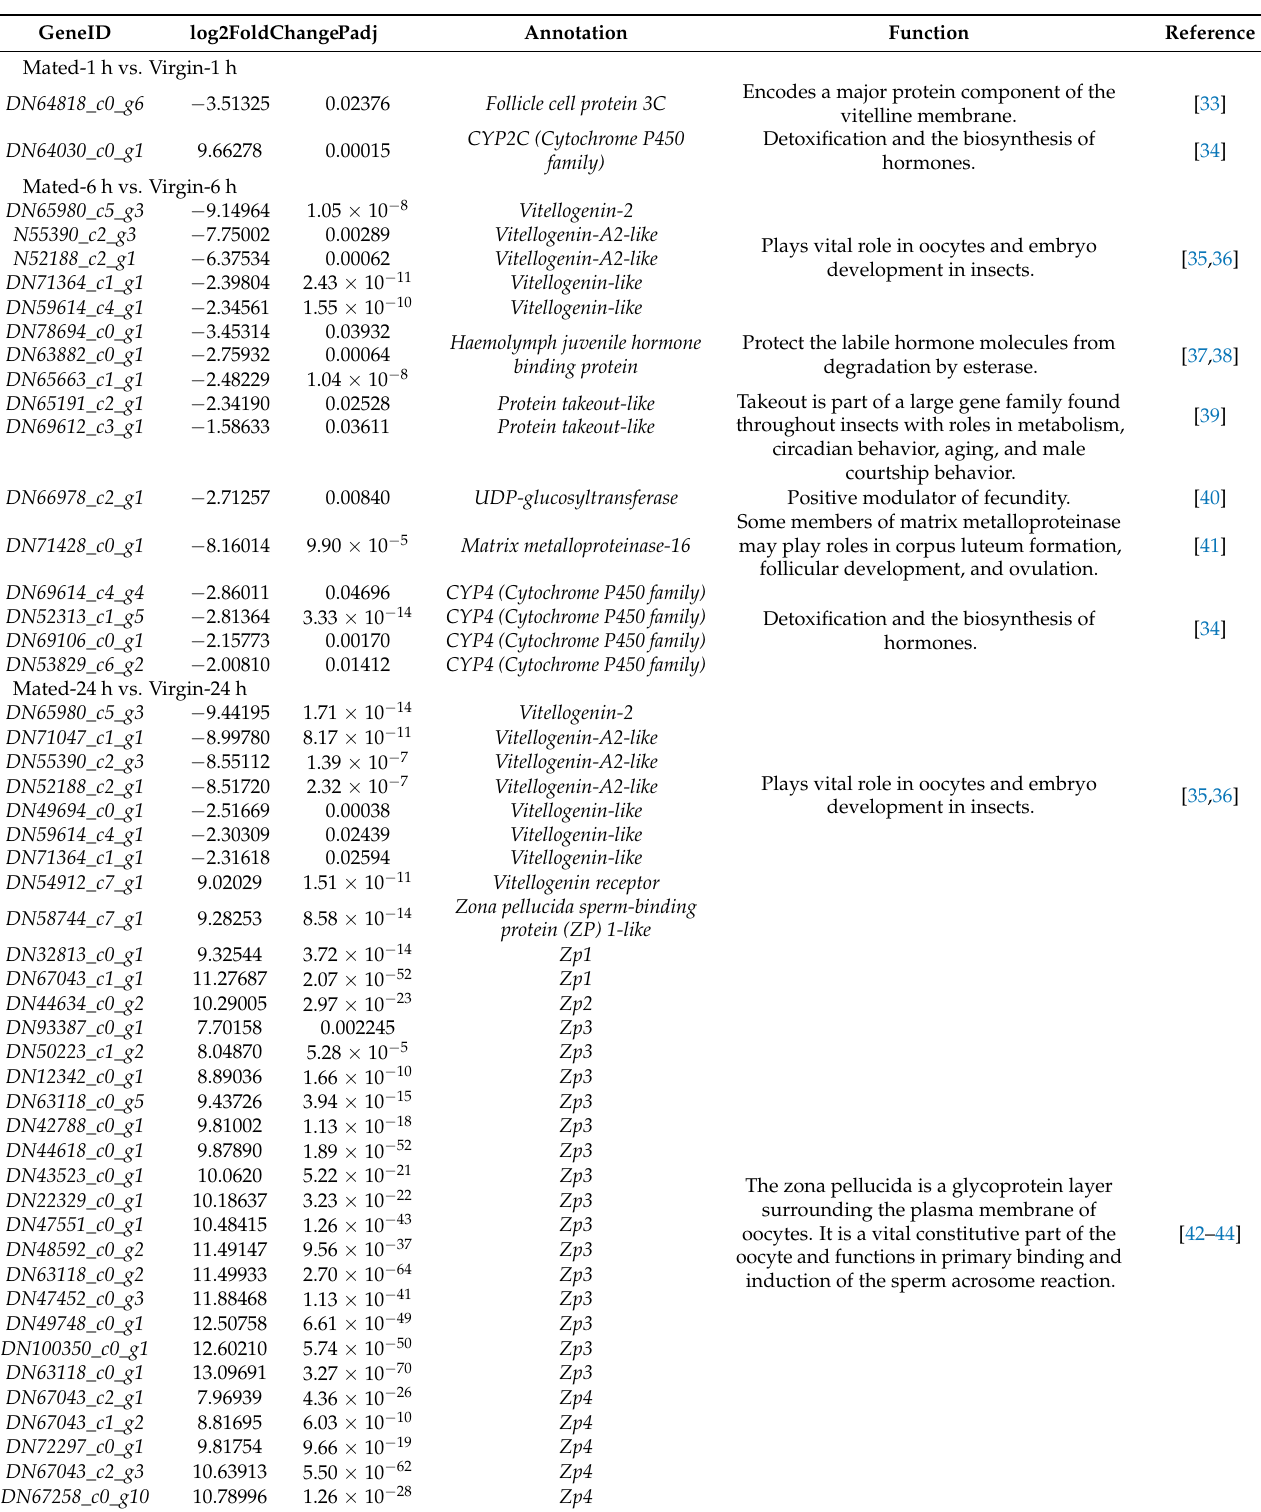
Table 1. Mating-induced expression changes in genes related to reproduction in C. chuxiongica females. GeneID log2FoldChangePadj Annotation Function Reference Mated-1 h vs. Virgin-1 h Encodes a major protein component of the Follicle cell protein 3C vitelline